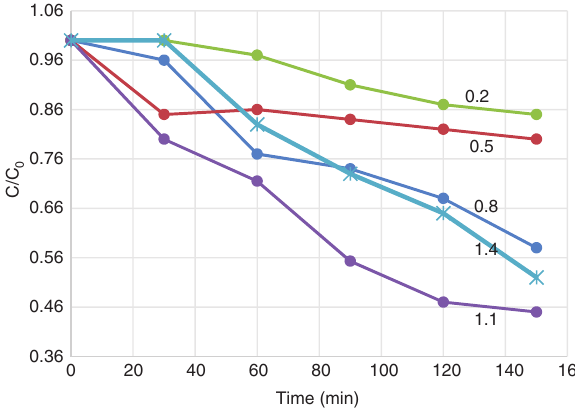
Figure 8: Influence of a various concentrations of CdO on STZ degradation ([STZ] = 30 mgL −1 , pH